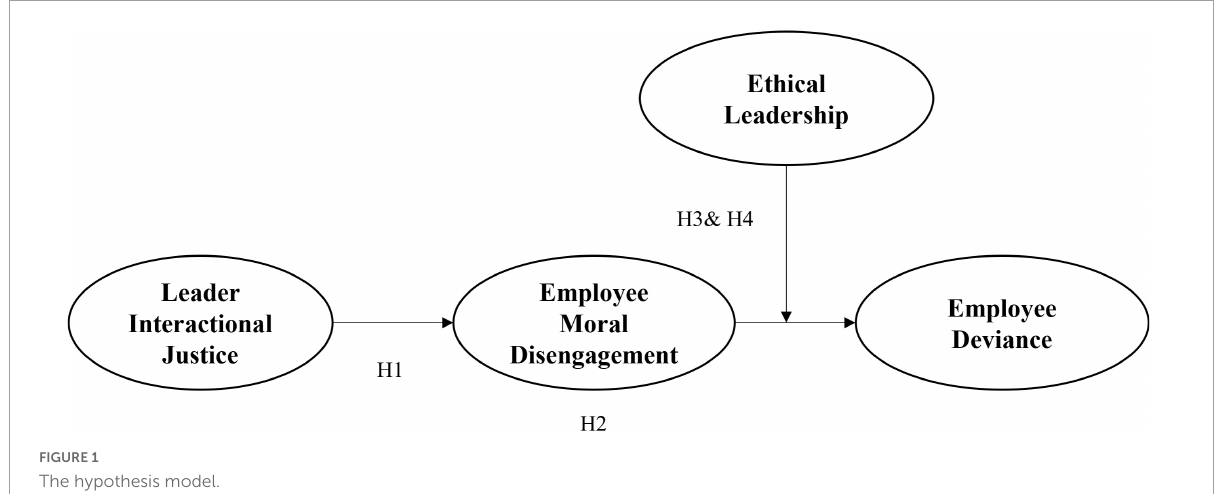
FIGURE1 The hypothesis